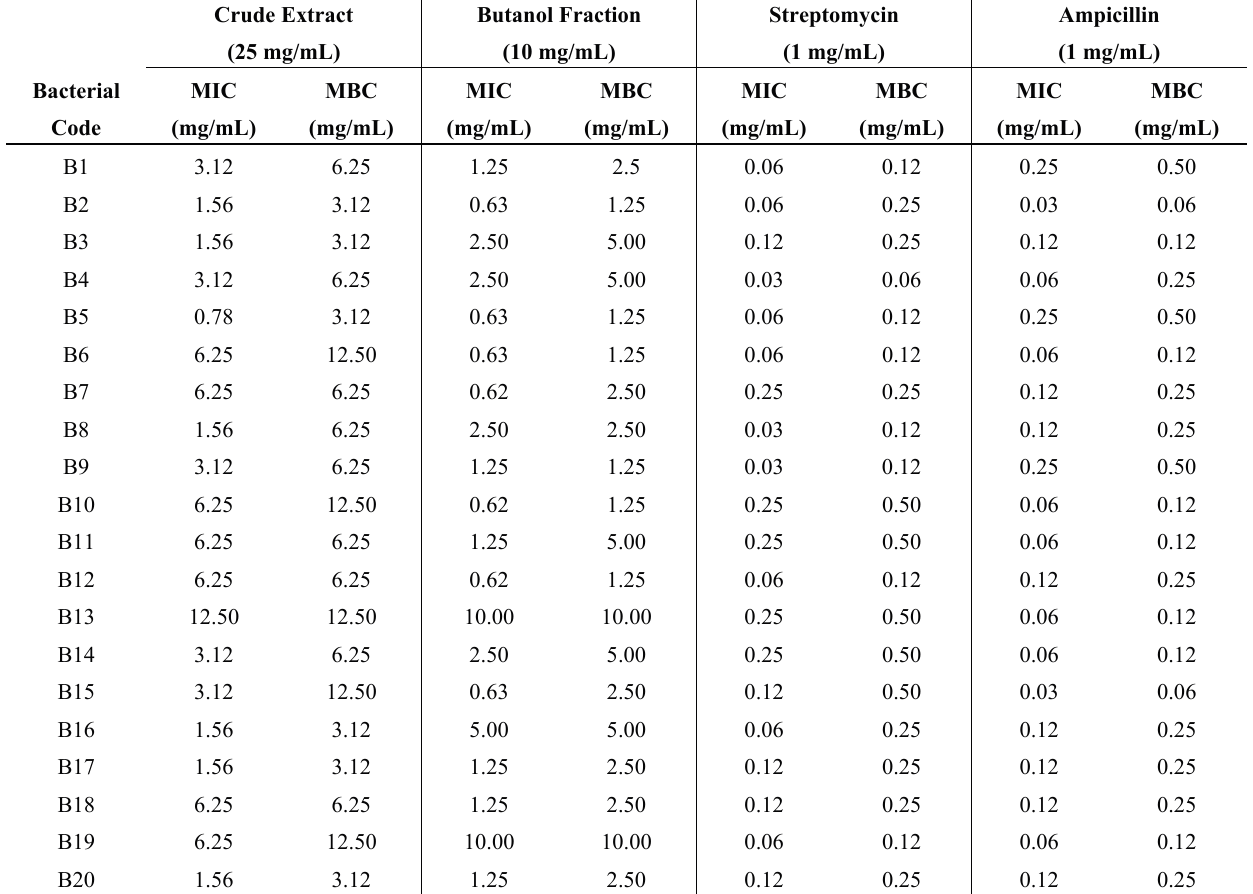
Table 3. The minimum inhibitory concentrations of the crude extract, butanol fraction and standard antibiotics exhibited against susceptible bacterial